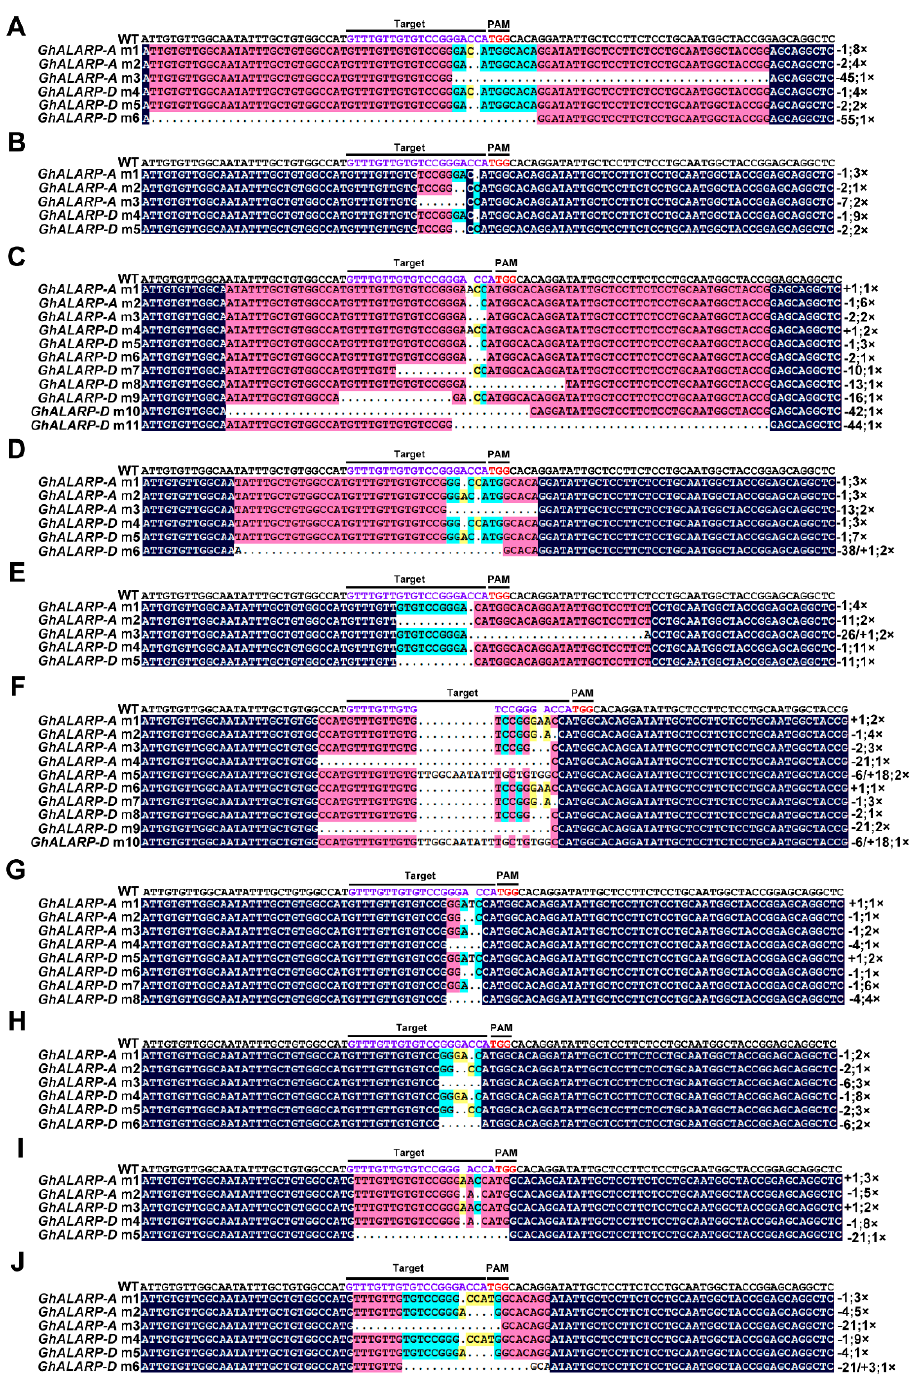
Figure 3. Sequence analysis of the target sites in GhALARP-A and GhALARP-D . ( A – J ) Alignment of genomic sequences of the target site and its flanking regions from the transgenic cotton lines (L1 to L10). The purple nucleotides indicate the target sequences of sgRNA in GhALARP . The red nucleotides indicate the PAM sequence. The frequency of each mutation and the mutation types are shown on the right.